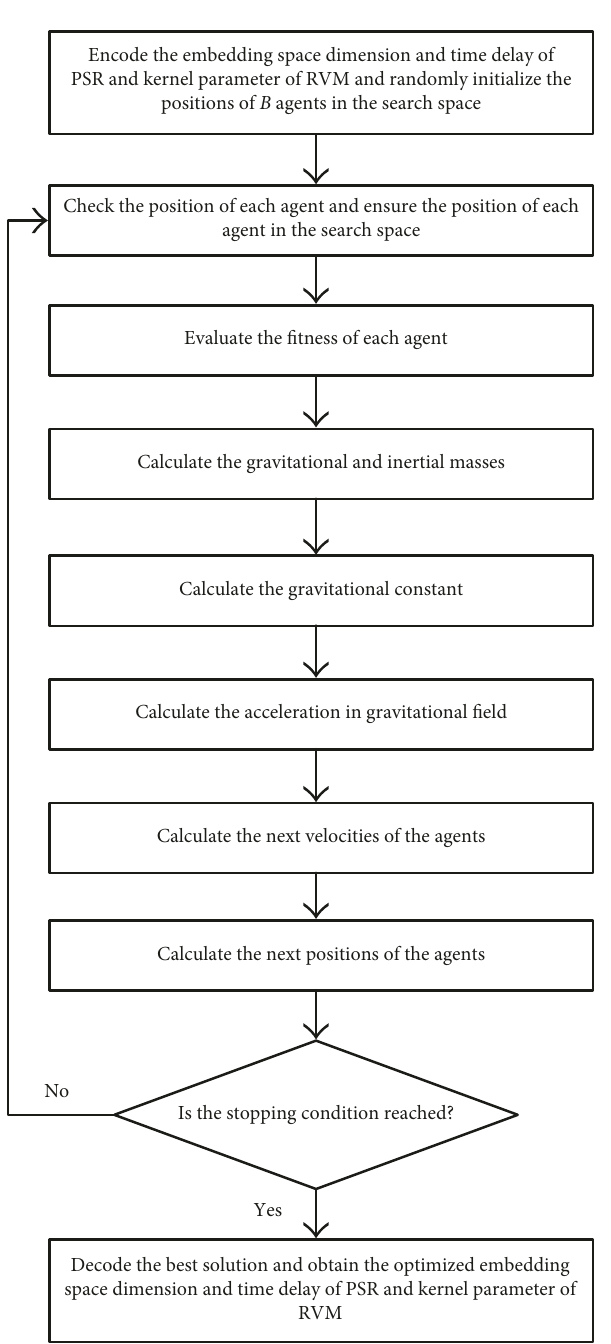
Figure 1: The process of the selection of m (embedding space dimension) and τ (time delay) of PSR and p (kernel parameter) of RVM by